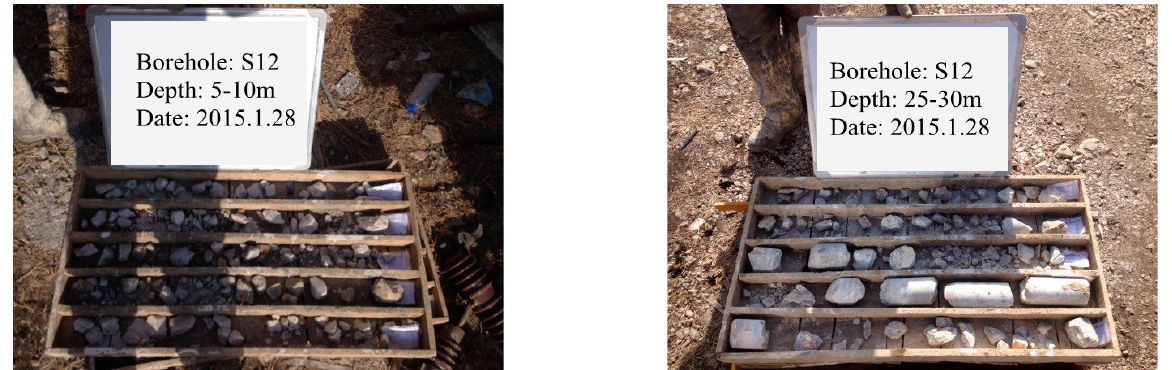
Figure 4. Drill cores of S12 from the depths of 5–10 m and 25–30 m.